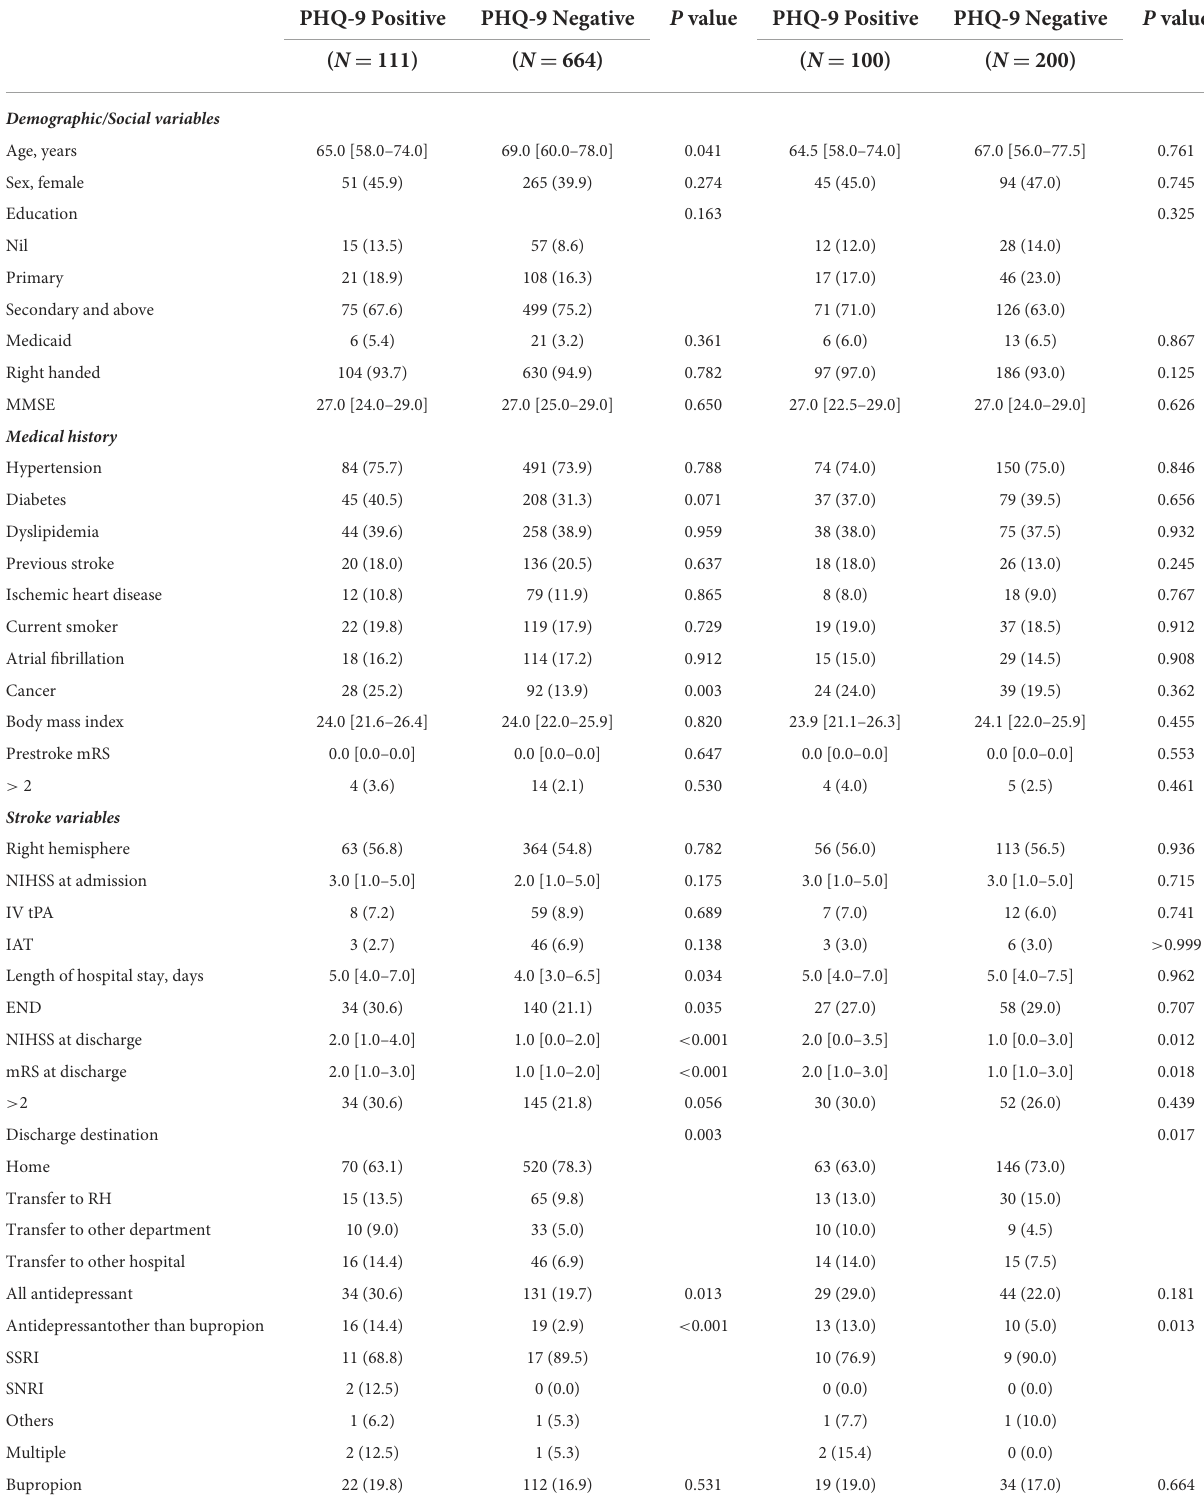
TABLE 1 Comparison of characteristics of patients stratified based on PHQ-9